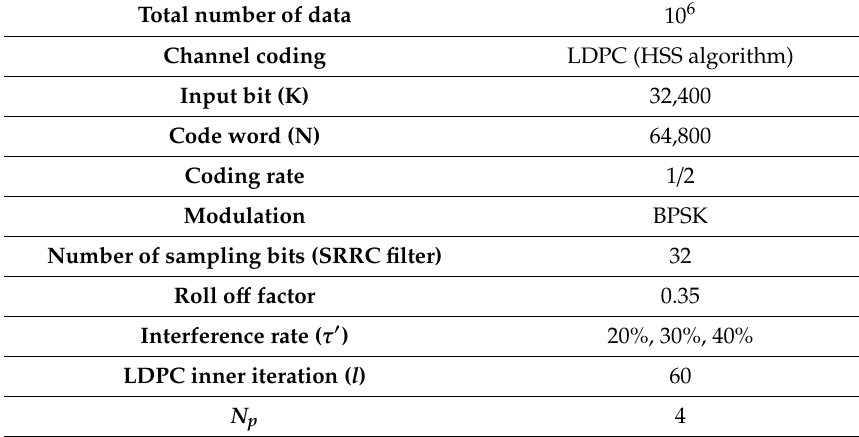
Table 1. Simulation parameters.